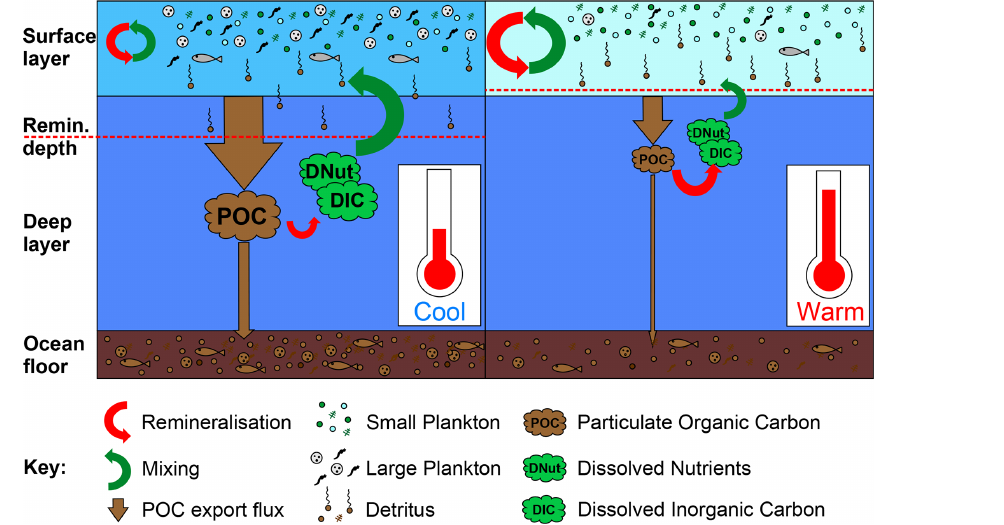
Figure 1. Schematic illustrating the impact of warming on the soft tissue biological pump. On the left side, under cooler pre-industrial con- ditions, cGEnIE’s surface layer remains fairly well mixed with the deep ocean (green arrow), returning dissolved nutrients and carbon (DNut and DIC respectively) from the remineralisation of exported particulate organic carbon (POC; red arrow), while some POC is remineralised partly within the surface layer (surface red arrows). On the right side, warming leads to a shift to dominance by smaller plankton as well as stratification, leading to less mixing between the shallow and deep ocean, while shoaling of the remineralisation depth leads to greater recycling of nutrients and carbon close to the surface layer; these processes combine to result in an overall reduction in POC export and sedimentation and an overall increase in the residence time of nutrients and carbon in the